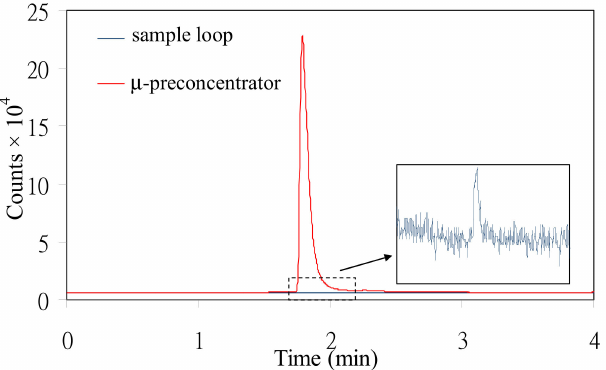
Figure 4. GC-FID signals of the 200 ppb ethyl acetate injection with a 100 µ L sample loop and a µ -preconcentrator after sampling for 2.4 L and direct thermal desorption/injection. The sampling flow rate was 40